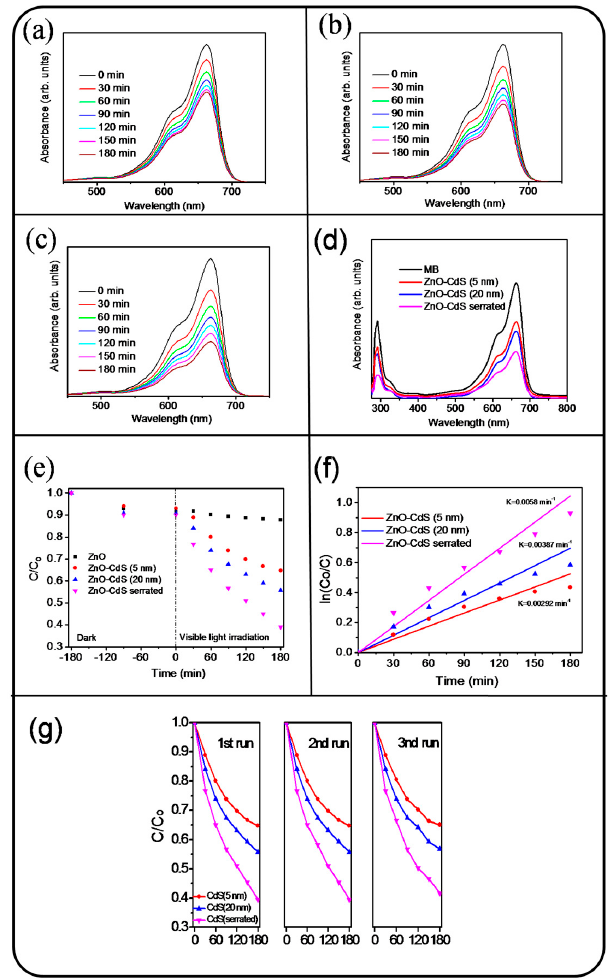
Figure 6. Intensity variation of absorbance spectra of MB solution vs. degradation duration containing various nanorod samples under visible-light illumination: ( a ) ZnO-CdS (5 nm) nanorods; ( b ) ZnO-CdS (20 nm) nanorods; ( c ) ZnO-CdS nanorods annealed; ( d ) intensity variation of absorbance spectra of MB solution containing various rod samples after 180 min visible-light illumination in the wavelength range from UV to visible region; ( e ) C/C o vs. irradiation time curves for MB solution with various nanorods samples in dark conditions and under visible-light illumination; ( f ) plot of ln(C o /C) vs. reaction time for MB solution containing various nanorod samples under visible-light illumination; ( g ) recycled performances (three test runs) in the presence of various ZnO-CdS nanorods for photodegradation of MB